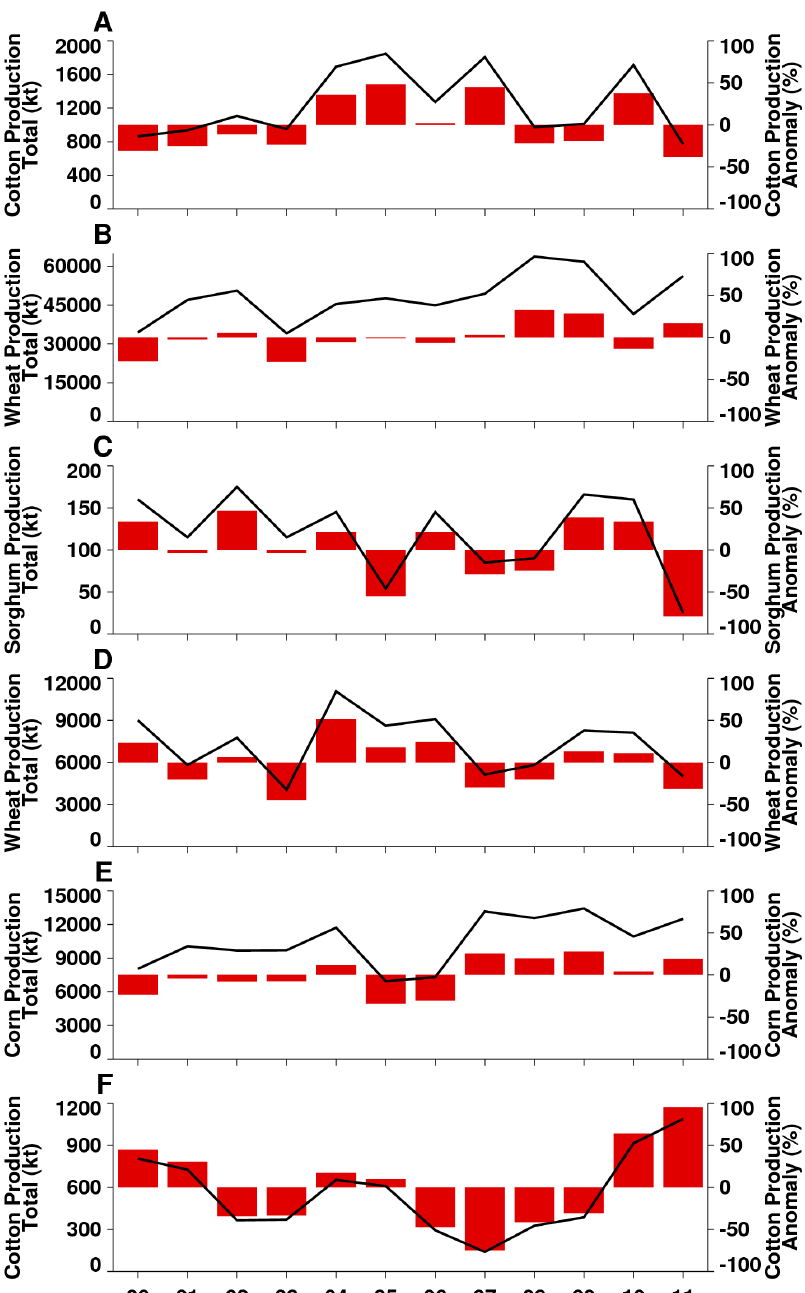
Figure 3. Crop production time series for selected regions in 2000–2011 expressed as annual totals (represented by the black line) and as annual anomalies, i.e., departures from the decadal mean (represented by the red bar